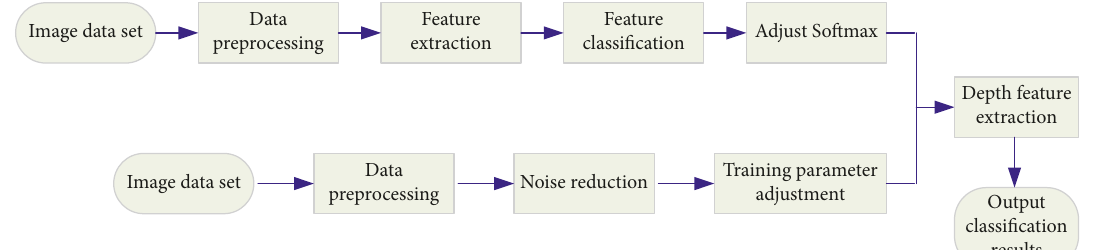
Figure 8: Working diagram of improved image classification algorithm.